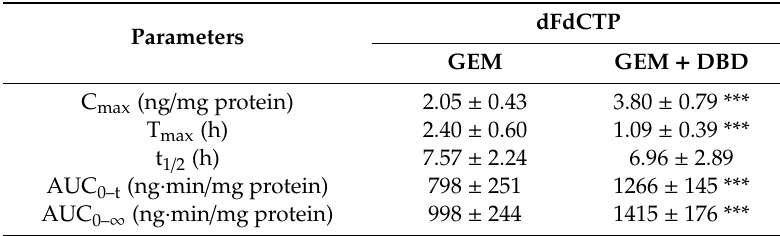
Table 2. Pharmacokinetic parameters of dFdCTP in rat PBMC after single administration of GEM and GEM + DBD. Data are shown as mean ± SD ( n = 10), *** p < 0.001 compared with the GEM group.